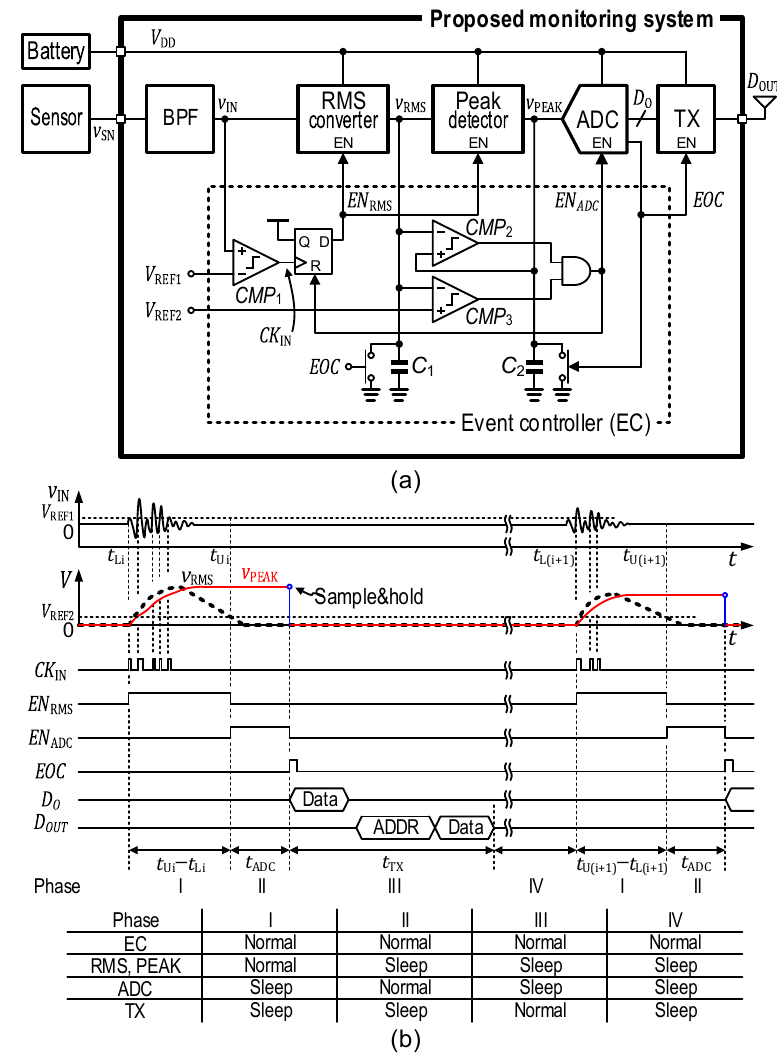
Figure 7. Proposed monitoring system. ( a ) Detailed circuit and ( b ) timing diagram.